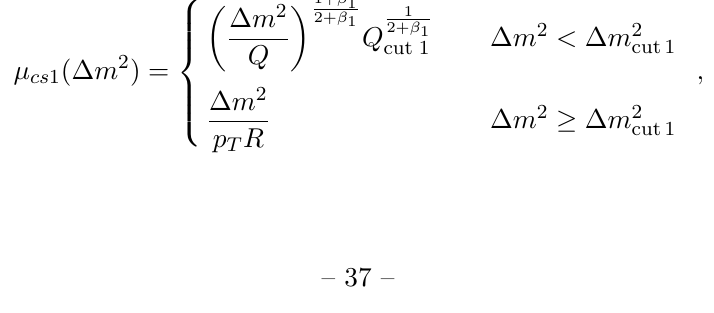
) 1 = 2 from eq. (4.46). The cut1 ) 1 = 2 , where all the curves meet at the far right, cut2